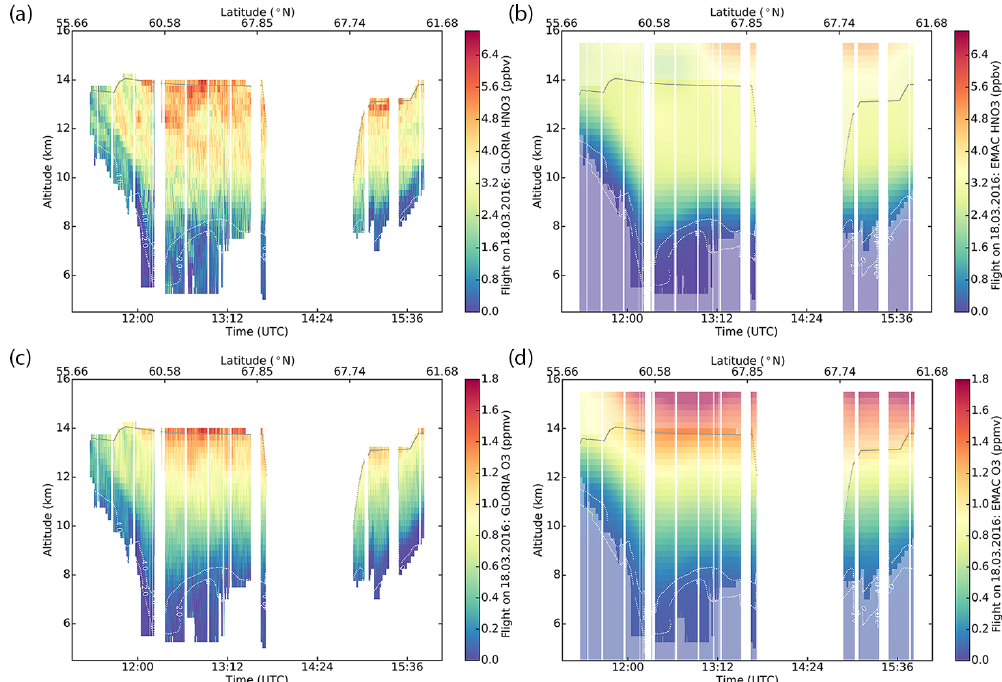
Figure 15. GLORIA HNO 3 and O 3 observations during flight 21 on 18 March 2016 (a, c) and EMAC T106L90 output along the flight track (b, d)